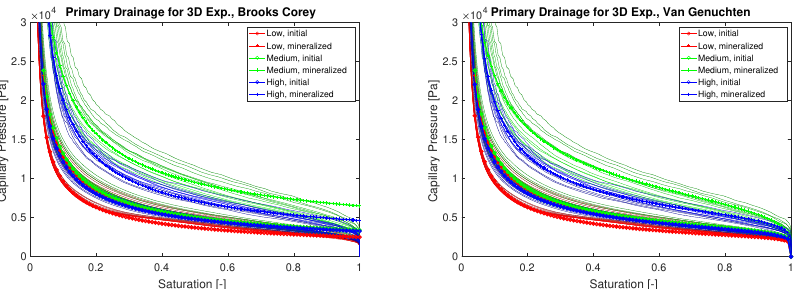
Figure 12. Capillary pressure–saturation curves for 13 sections of the mineralized and unmineralized 3D experiment columns each with Brooks–Corey (Equation (4)) ( left ) and Van Genuchten relations (Equation (5)) ( right ) fitted to each ensemble of capillary pressure–saturation curves obtained for each column in unmineralized and mineralized